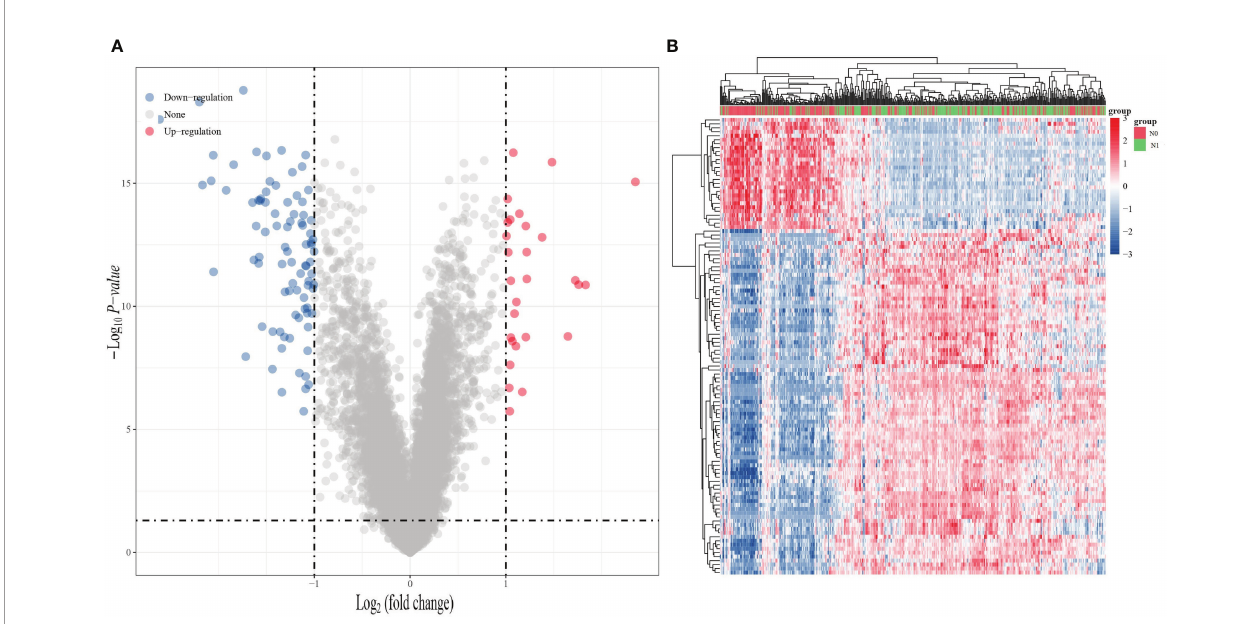
FIGURE 1 | Gene expression analysis of whether THCA is lymphatic metastasis or not. (A) Volcano plot of differentially expressed RNA between THCA lymphatic metastasis and non-lymphoid metastasis in the TCGA dataset. (B) Heat map of differentially expressed RNA in the TCGA dataset. (Blue: downregulated expression; red: upregulated